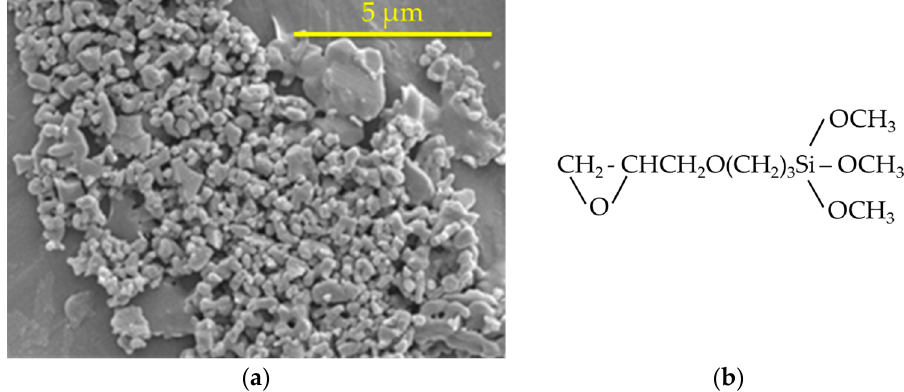
Figure 1. ( a ) SEM image of the alumina particles; ( b ) Chemical structure of the silane coupling agent used in this work, ( γ )-Glycidoxypropyl-trimethoxy silane